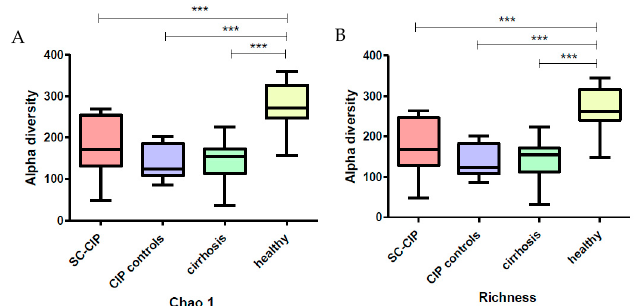
Figure 1. Boxplots showing levels of mean alpha diversity of Secondary Sclerosing Cholangitis in Critically Ill Patients (SC-CIP) (red), patients after critical illness without liver disease (CIP controls) (violet), cirrhosis (green) and healthy (yellow) groups using Chao 1 ( A ) and Richness Index ( B ). Significances are indicated by stars. *** p ≤ 0.001. For statistical analysis, analysis of variance (ANOVA) with Bonferroni correction was used.